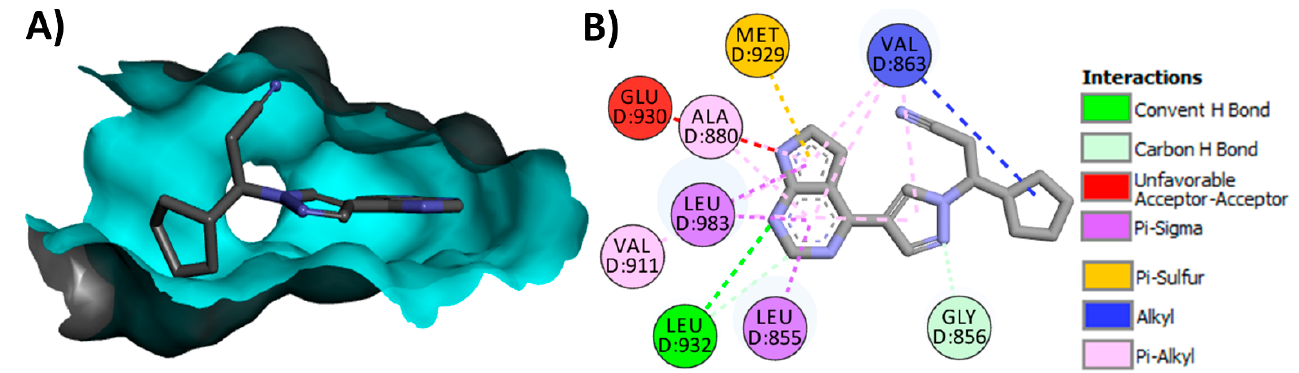
Figure 54. Binding modes of ruxolitinib (shown as sticks) into JAK2 JH1 (pdb: 6VNK): ( A ) 3D binding mode, receptor shown as a hydrogen bond surface; ( B ) 2D binding mode showing different types of interactions with JAK2 JH1; hydrogen atoms were omitted for clarity; this figure was generated using Discovery Studio Visualizer (V16.1.0.15350).